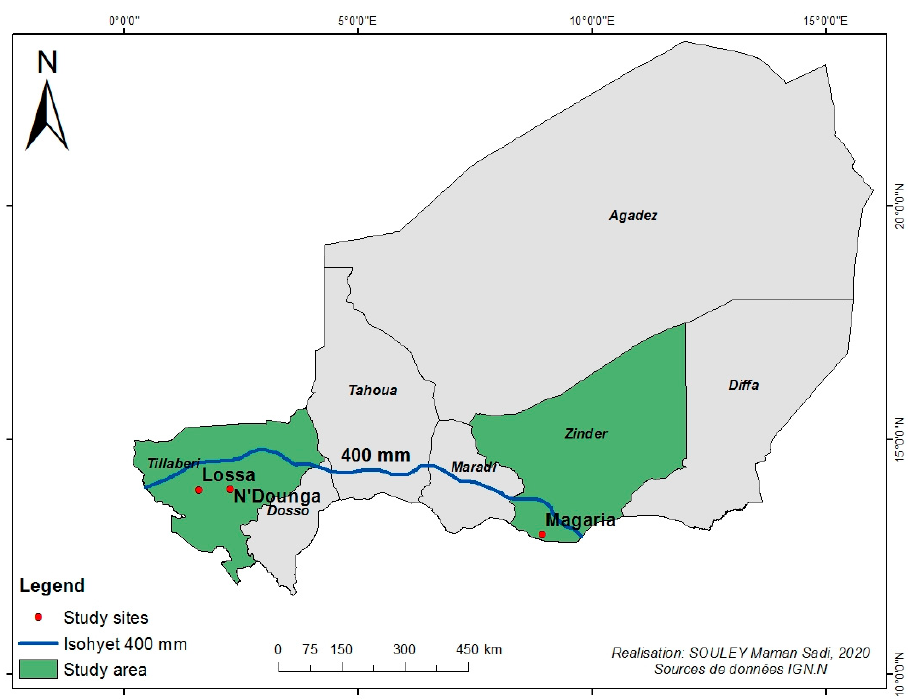
Figure 1. Map of agro-climatic zones in Niger and location of study sites.